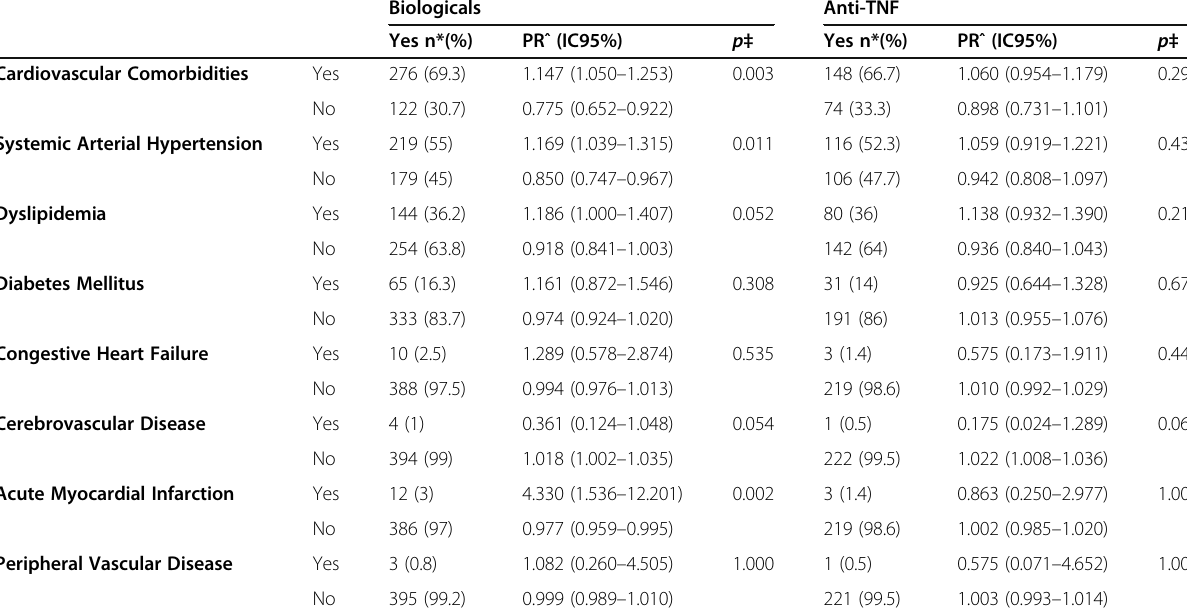
Table 6 Association between cardiovascular comorbidities and use of biologicals, in particular those of the anti-TNF